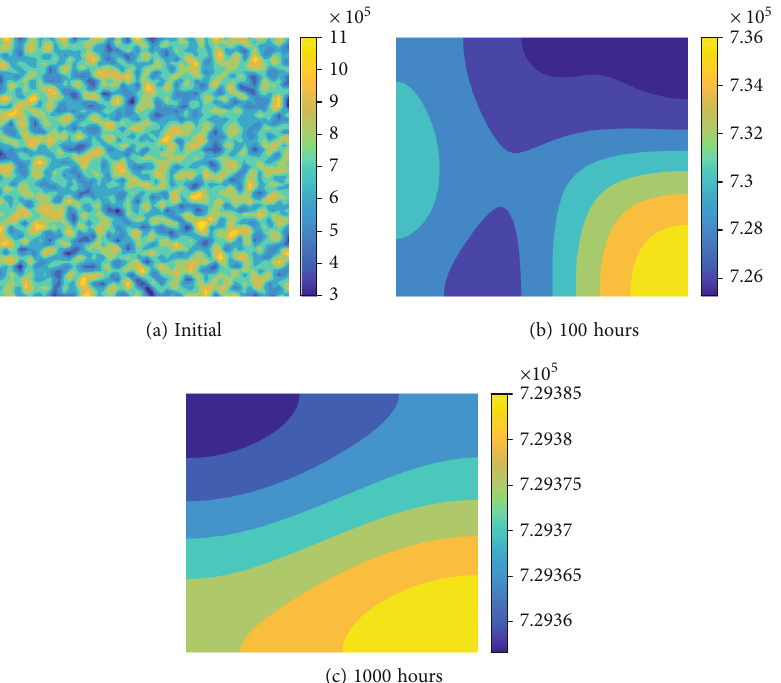
Figure 2: Pressure distributions computed by the proposed model in example 1 at di ff erent times.